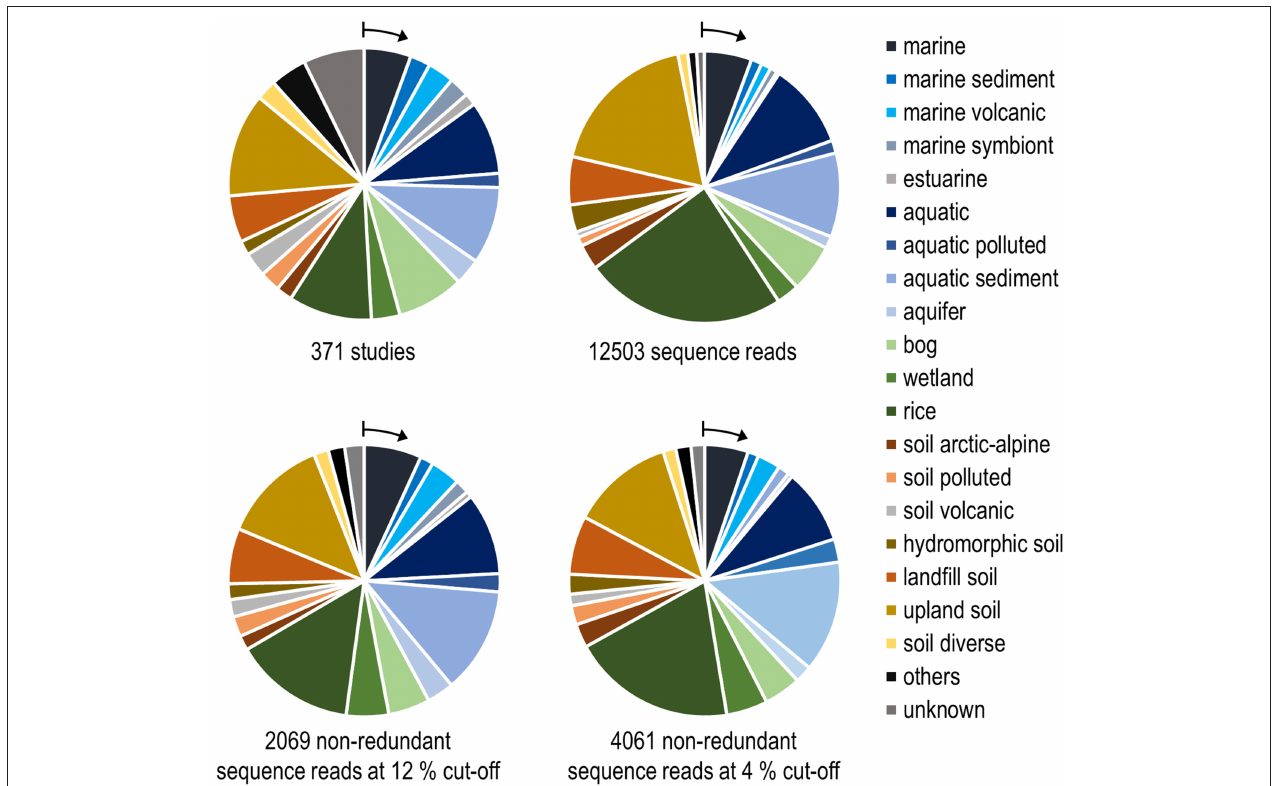
FIGURE 5 | Number of habitats that were analyzed in research studies (upper left) and grouping of pmoA sequences from the NCBI database according to the habitats in which they were detected. The upper right diagram is based on all available high quality sequences, while the lower diagrams include only non-redundant sequence reads. Redundant reads are those that were detected in the same study and fall within the same OTU. Arrows denote the position of the group that is shown as first entry in the